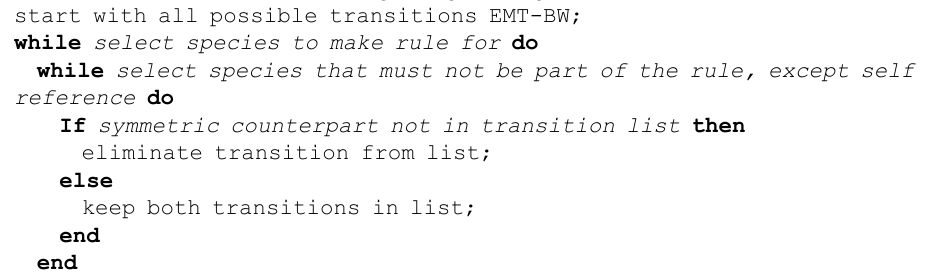
Algorithm 1: Model selection using biological insight.